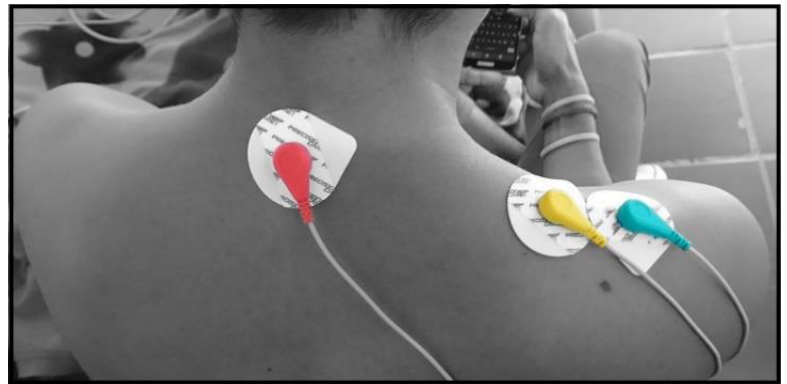
Figure 7. Electrodes location for EMG testing.